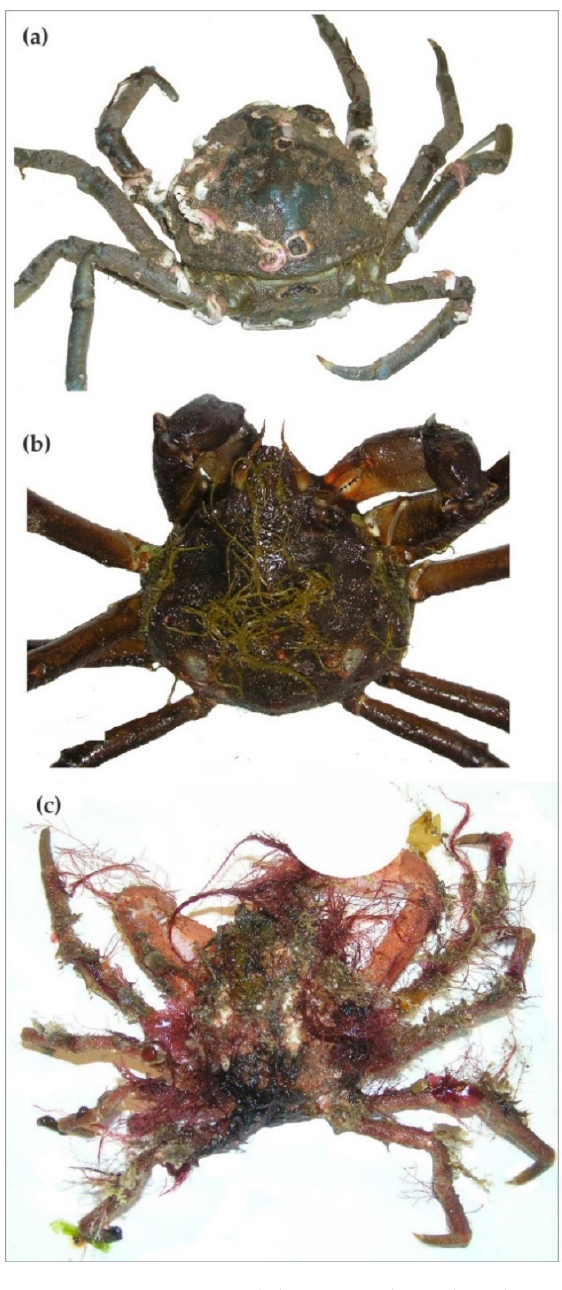
Figure 1. Hyas araneus . Adult great spider crabs colonized by the brown algae, Dictyosiphon foeniculaceus, ( a ) the polychaete, Spirobranchus triqueter ( b ), and a young crab decorated with epiphytes ( c ).